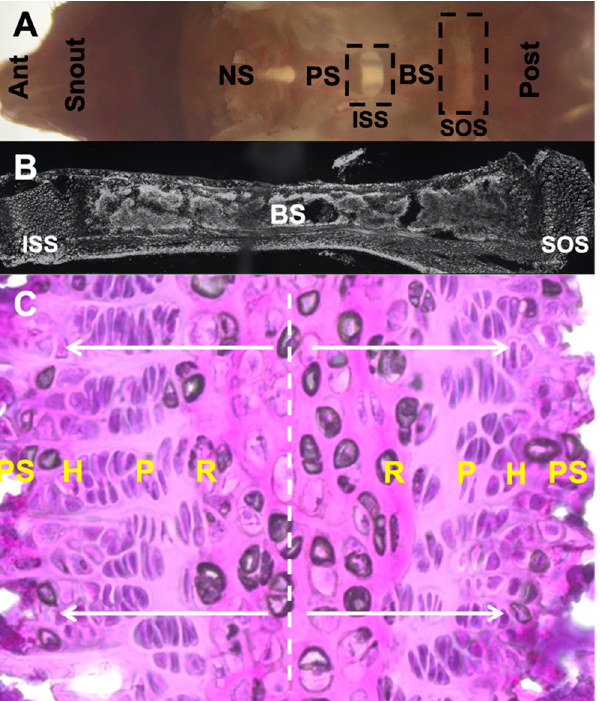
Figure 1. Morphology of cranial base and SOS harvested at postnatal day 28 from C57BL/6 mouse. ( A ). Gross morphology of dissected cranial base positioned in an anteroposterior manner. ( B ). Sagittal section of ISS, basi-sphenoid bone and SOS. ( C ). Magnified image highlighting bidirectional arrangement of chondrocyte layers in SOS stained with hematoxylin and eosin and presence of presumptive central hypertrophic chondrocytes. Ant: anterior, NS: nasal septum, PS: pre-sphenoid, BS: basi-sphenoid, Post: posterior, ISS: inter-sphenoid synchondrosis, SOS: spheno-occipital synchondrosis, R: resting zone, P: proliferating zone, H: hypertrophic zone, PS: primary spongiosa.